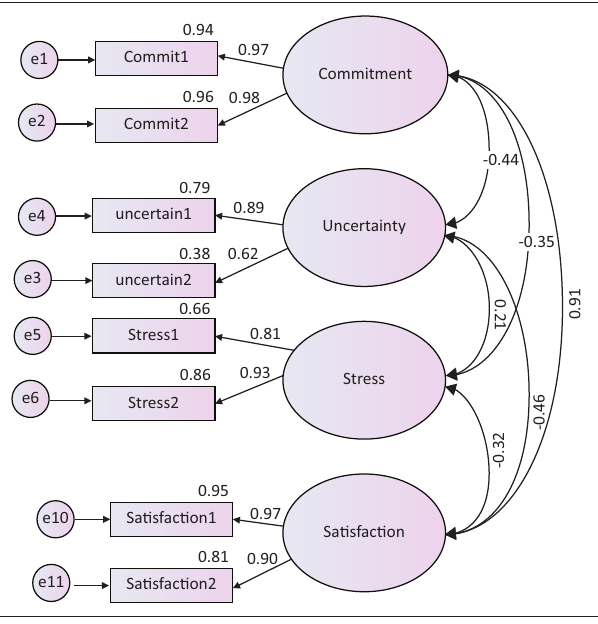
FIGURE 2: Measurement model.